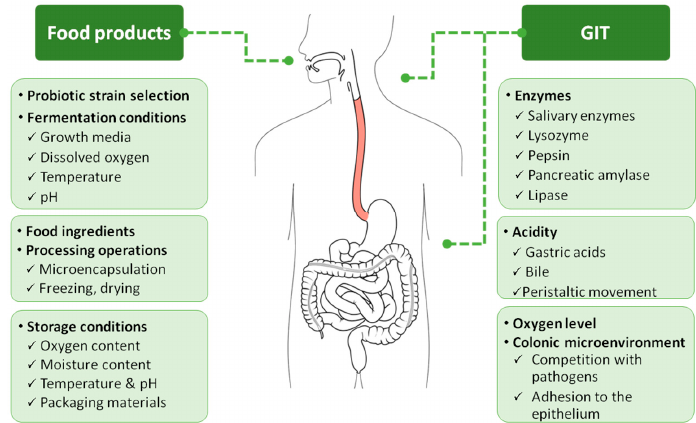
Figure 2. Factors affecting viability of probiotics in food products (during processing and storage), as well as in the gastrointestinal tract (GIT).